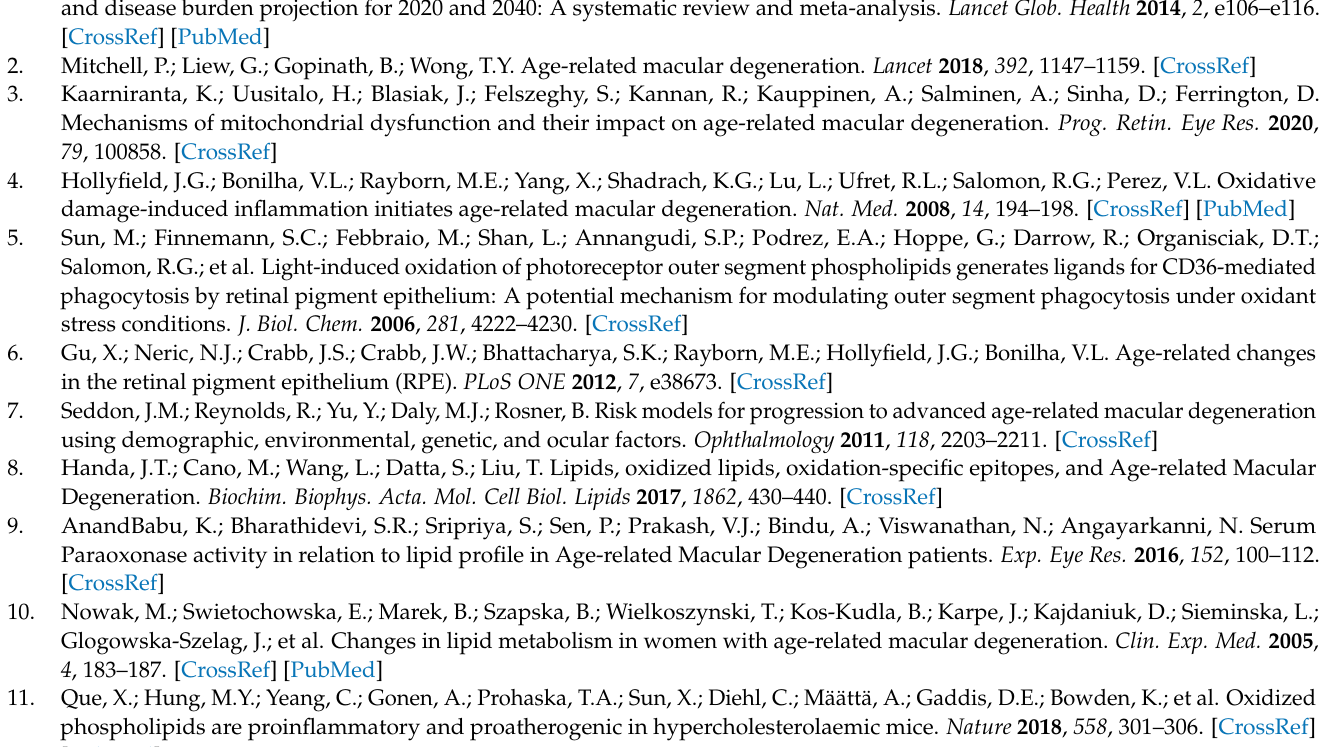
Table S2: PCR primers for mouse used in this study. Table S3: PCR primers for human used in this study. Figure S1: Effect of LXR agonist on OxLDL-induced experimental CNV. Immunofluorescence staining of frozen section, Ly6c labeled actived